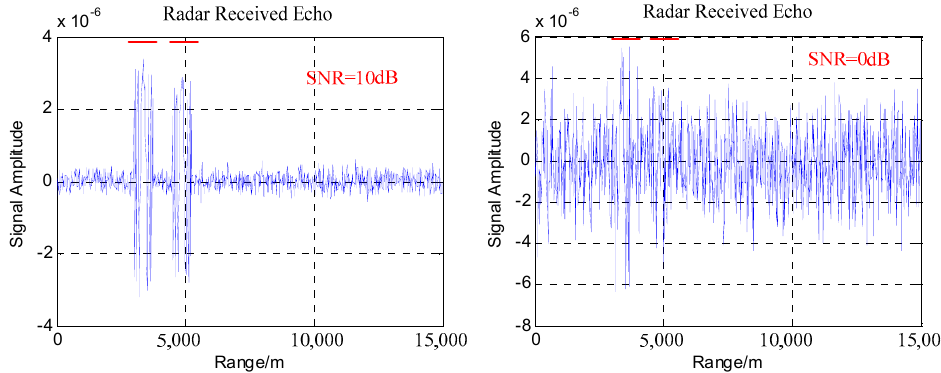
Figure 20. Example of simulated radar received echoes with different SNR, left : SNR = 10 dB, right : SNR = 0 dB.